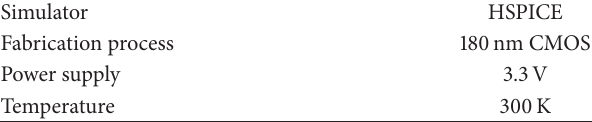
Table 1: Relationship of 𝑅 𝑚 , nodes potential (S2 and PL), and applied pulse for the store operation.